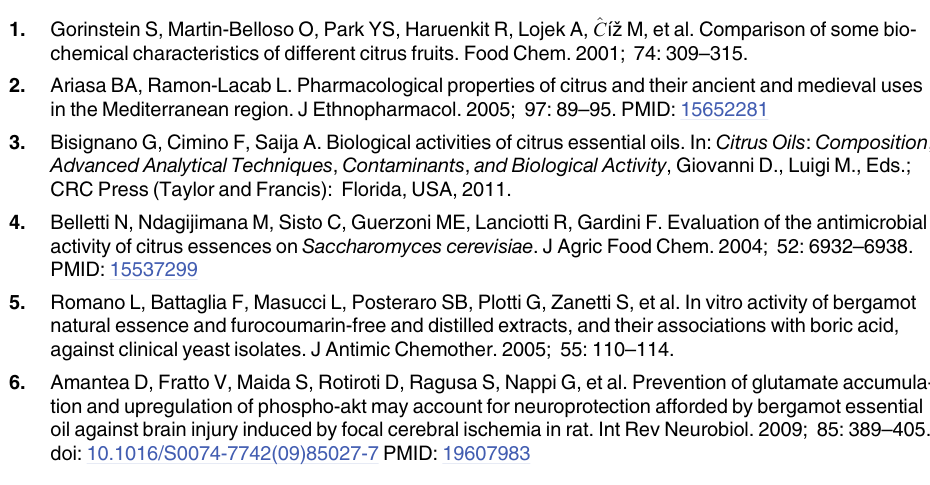
S1 Fig. Effects of C . limon , C . latifolia , C . limonia and C . aurantifolia essential oils on